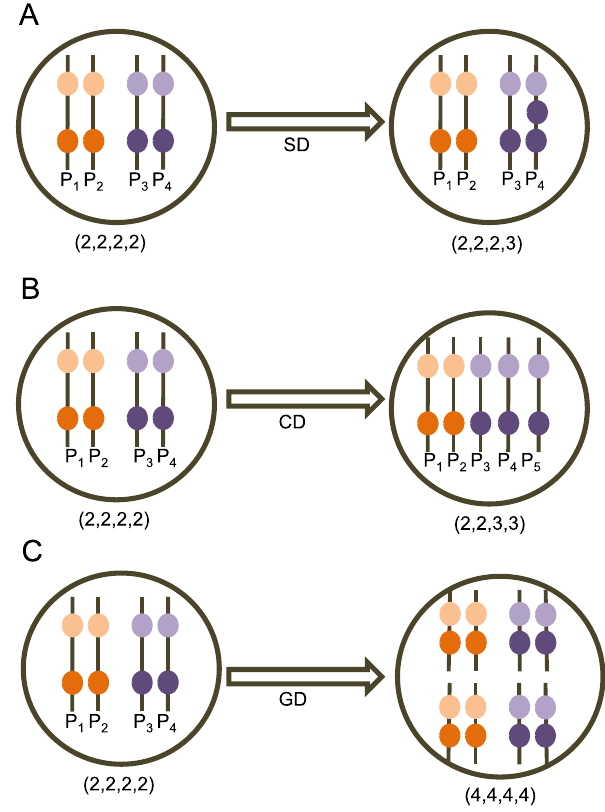
Figure 1. Example showing the three mechanisms of copy number changes in a hypothetical cell. A copy number profile of four genes is shown as an ordered set for homologous chromosome pairs P 1 , P 2 and P 3 , P 4 respectively, where the gene located on the top position in the chromosome precedes the gene located on the bottom position in the ordering. After the (A) Single gene duplication event, the copy number of a gene located on P 4 gets increased by 1. After the (B) Single chromosome duplication event, the chromosome P 4 gets duplicated and the cell has one extra copy of that chromosome as chromosome P 5 . After the (C) Whole genome duplication event, all the chromosomes are duplicated and the total number of chromosomes in the daughter cell is twice the number of chromosomes in the mother cell.